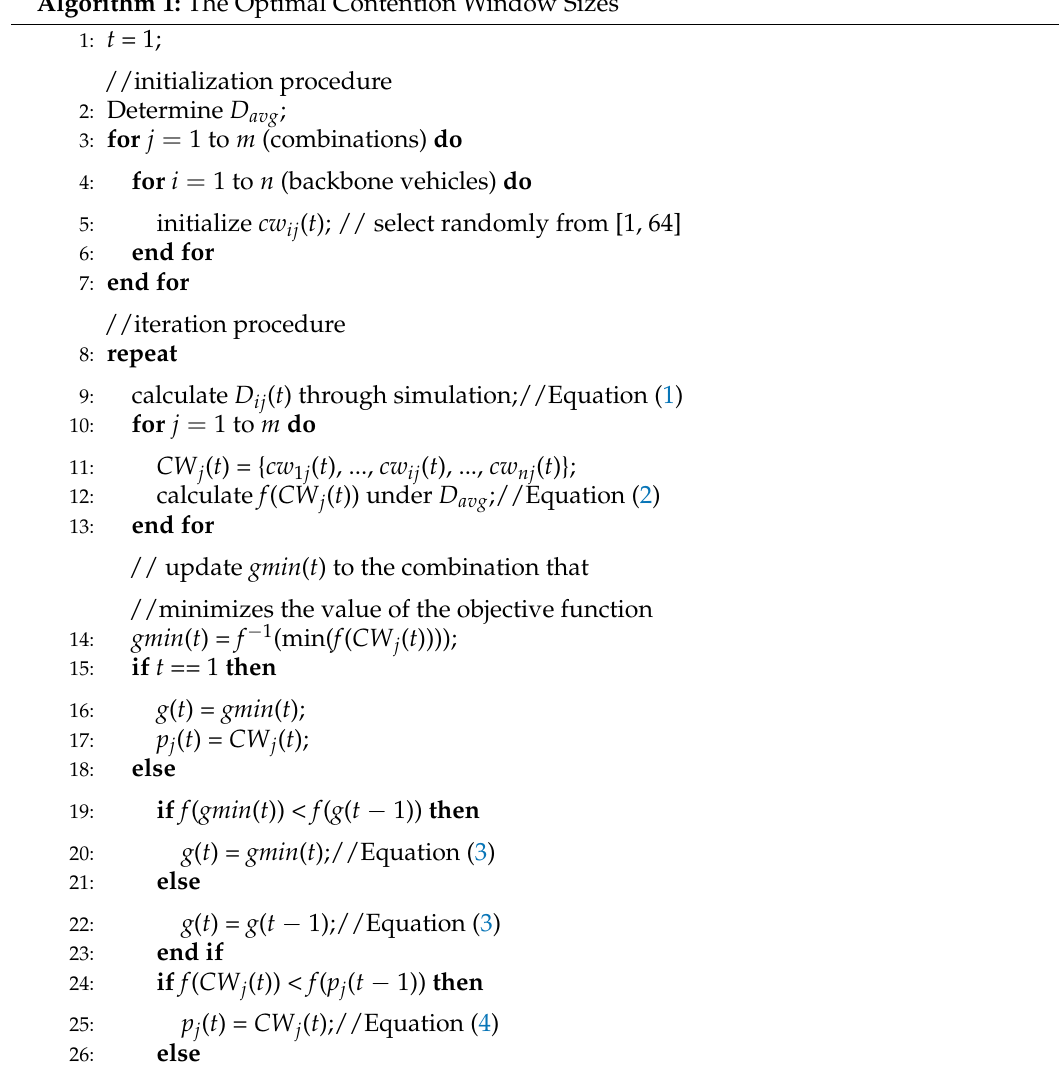
Algorithm 1: The Optimal Contention Window